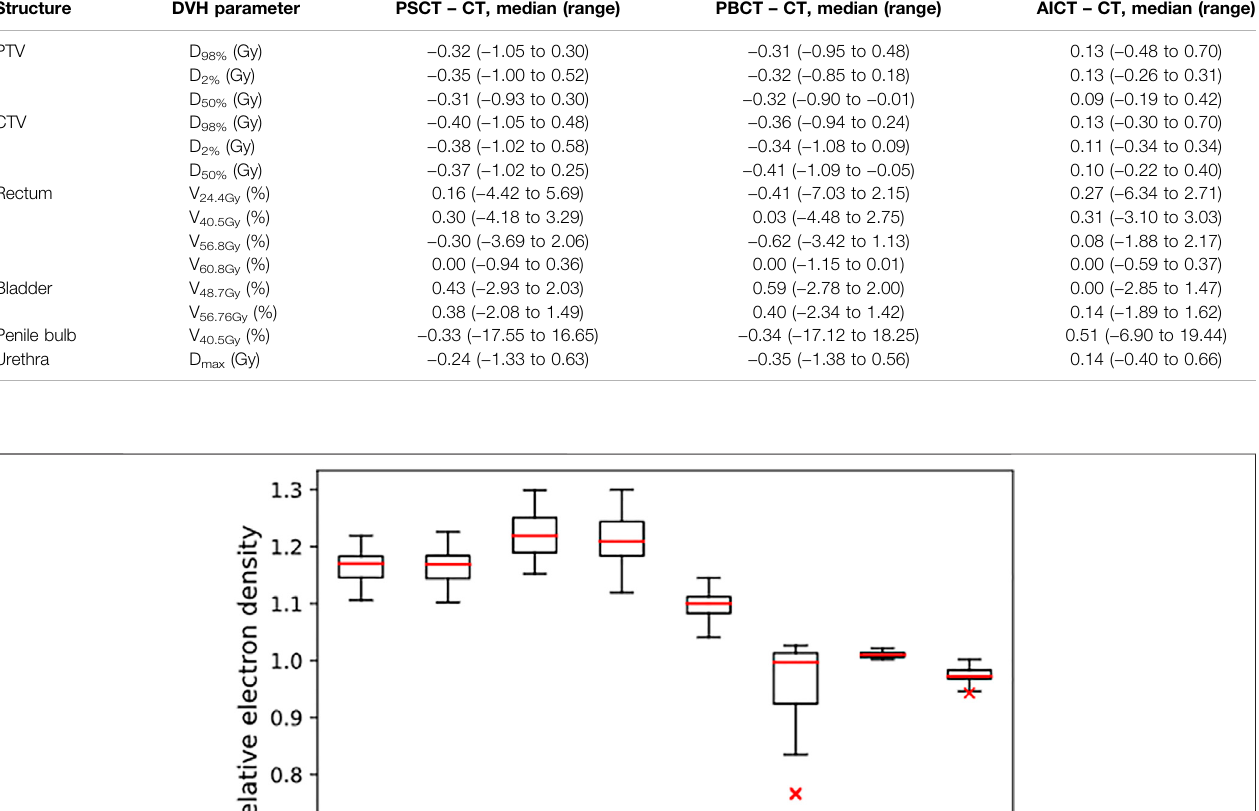
The GS dose calculation was reproduced for the evaluated DVH criteria with a maximum median deviation of − 0.41 Gy for the target parameters. The D 98% for PTV and CTV showed a median (range) deviation of − 0.31 ( − 0.95 to 0.48) Gy and − 0.36 ( − 0.94 to 0.24) Gy, respectively. The highest with − 0.62 ( − 3.42 to 1.13) Gy. The highest range deviation within the OARs was visible for the penile bulb with 35.37%. In comparison of the different methods is presented in Figures 2 and 3 .